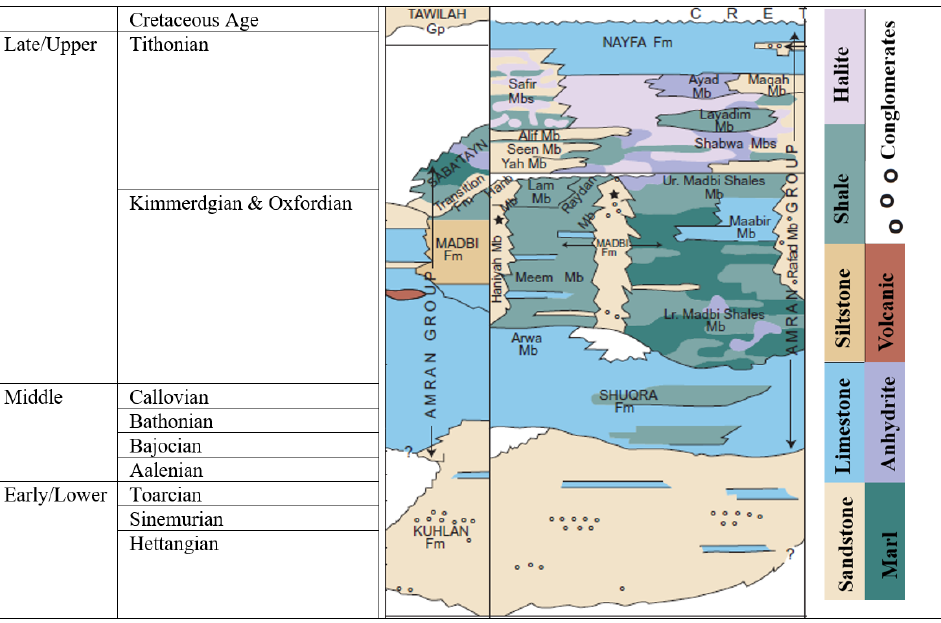
Figure 2. Geological, Hydrogeological units in the study area.